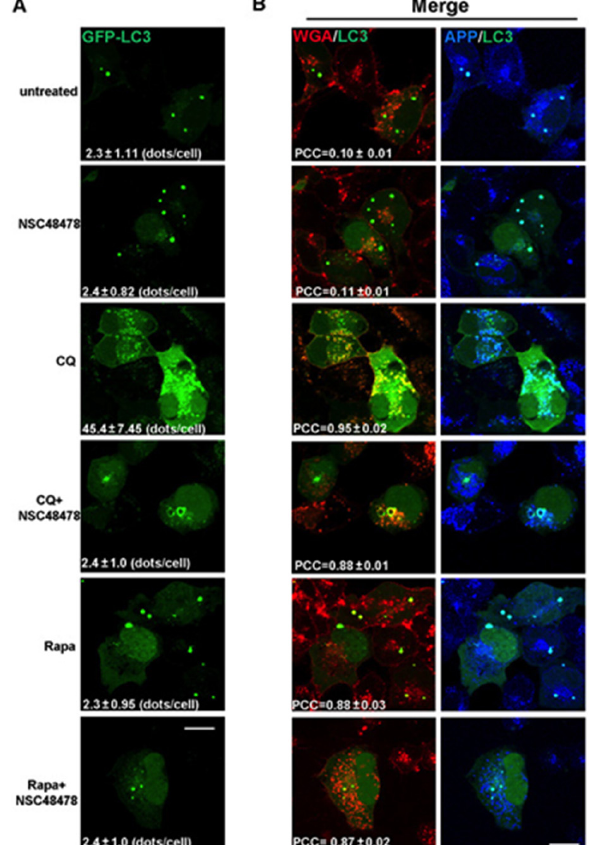
Figure 2. NSC48478 treatment induces formation of ring-shaped structures that are positive for LC3 and are of endocytic origin. ( A ) GT1 cells transiently transfected for GFP-LC3 were grown in low serum (1%) medium and left untreated (first upper panels), or treated as indicated. Cells were processed for immunofluorescence assay, and images were acquired by confocal microscopy. Panels show GFP-LC3 signal and number of LC3-positive dots/cell (±SEM). ( B ) The overlay (merge) be- tween red/green and green/blue channels is shown on the right panels. Panels show the localization of WGA (Alexa-555 red), GFP-LC3 (green) and APP (Cy5, blue). Pearson’s correlation coefficient is an average value (N = 25) and based on at least four independent experiments. Scale bars: 10 μ m; scale bars are shown on the bottom of figure and are the same for all panels.